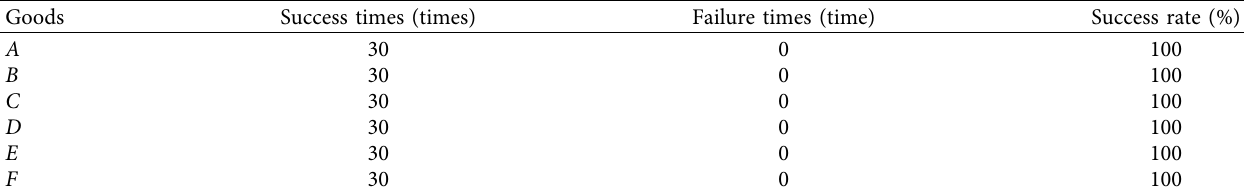
Table 2: Experimental results of static crawling when using the proposed method.